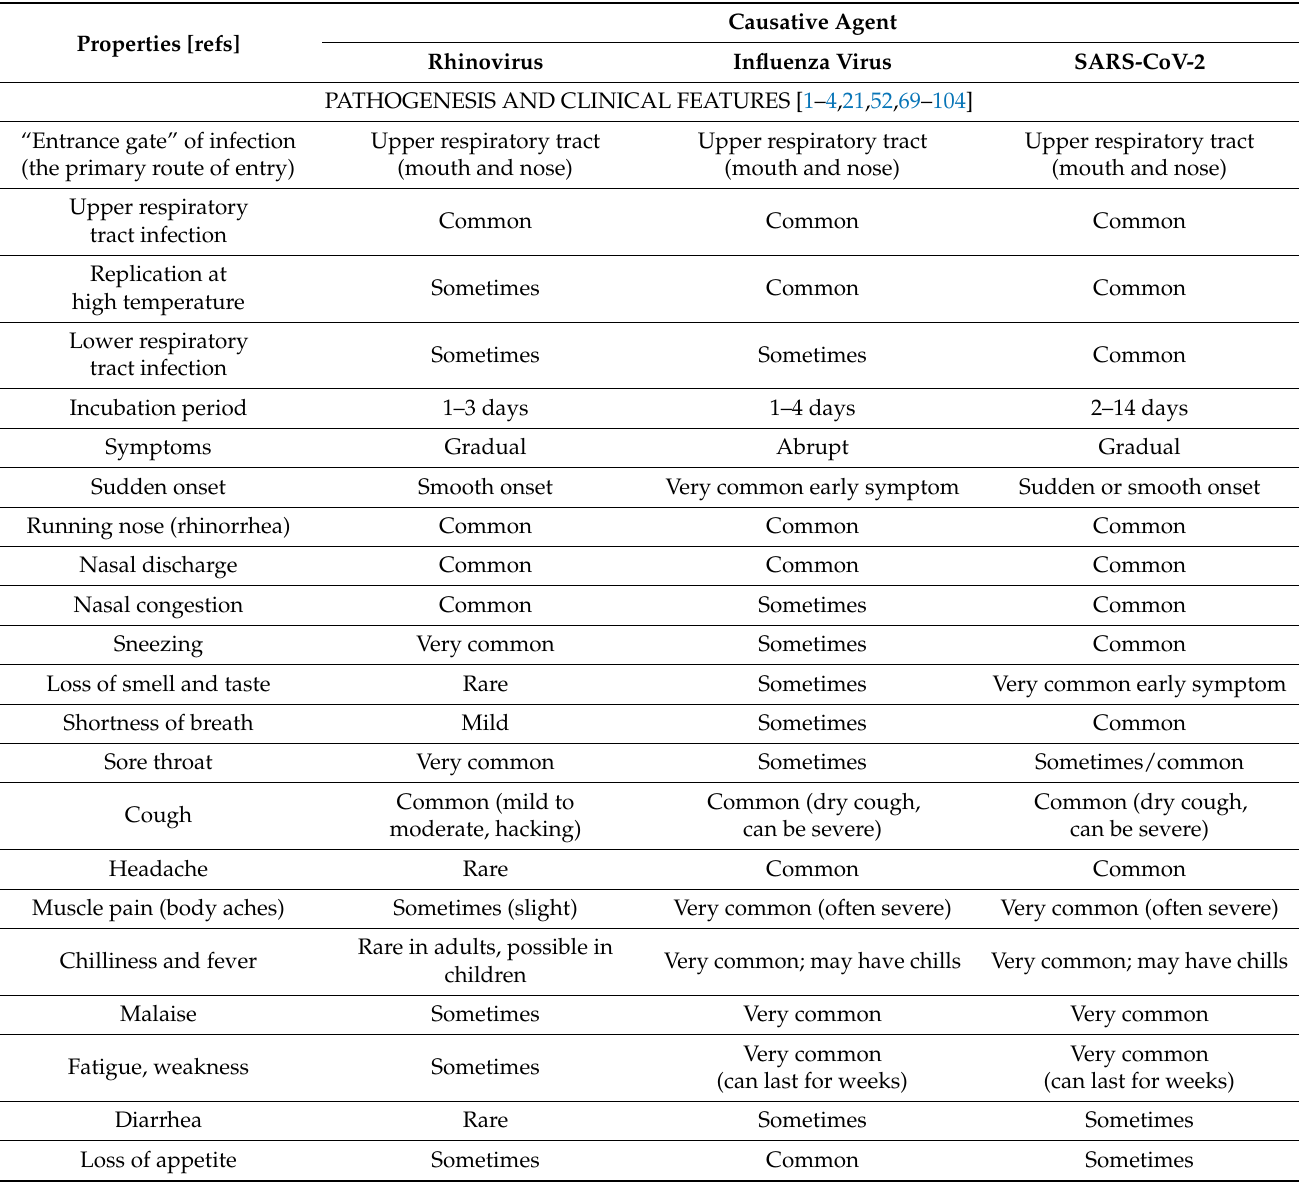
Table 2. Comparative characteristics of the common cold, influenza, and COVID-19: